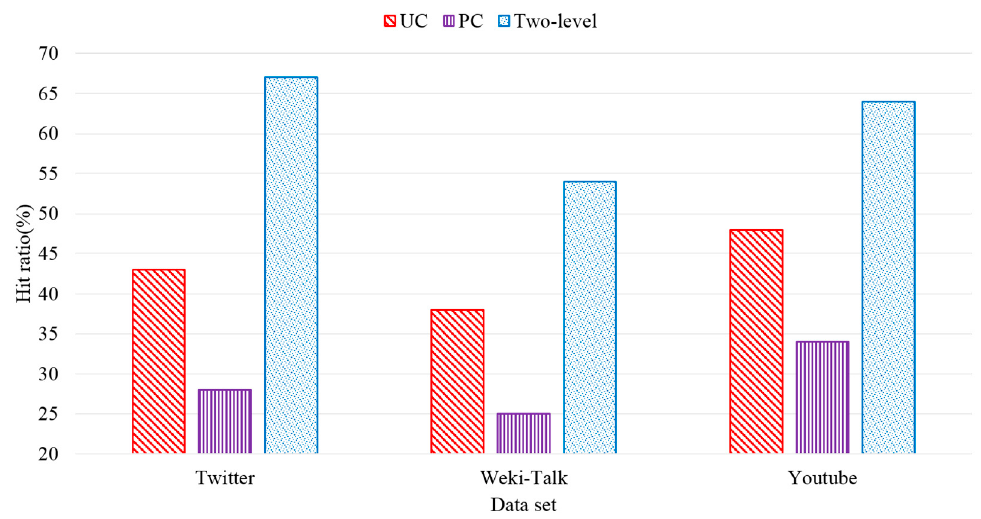
Figure 10. Hit ratio of single and two-level caches.